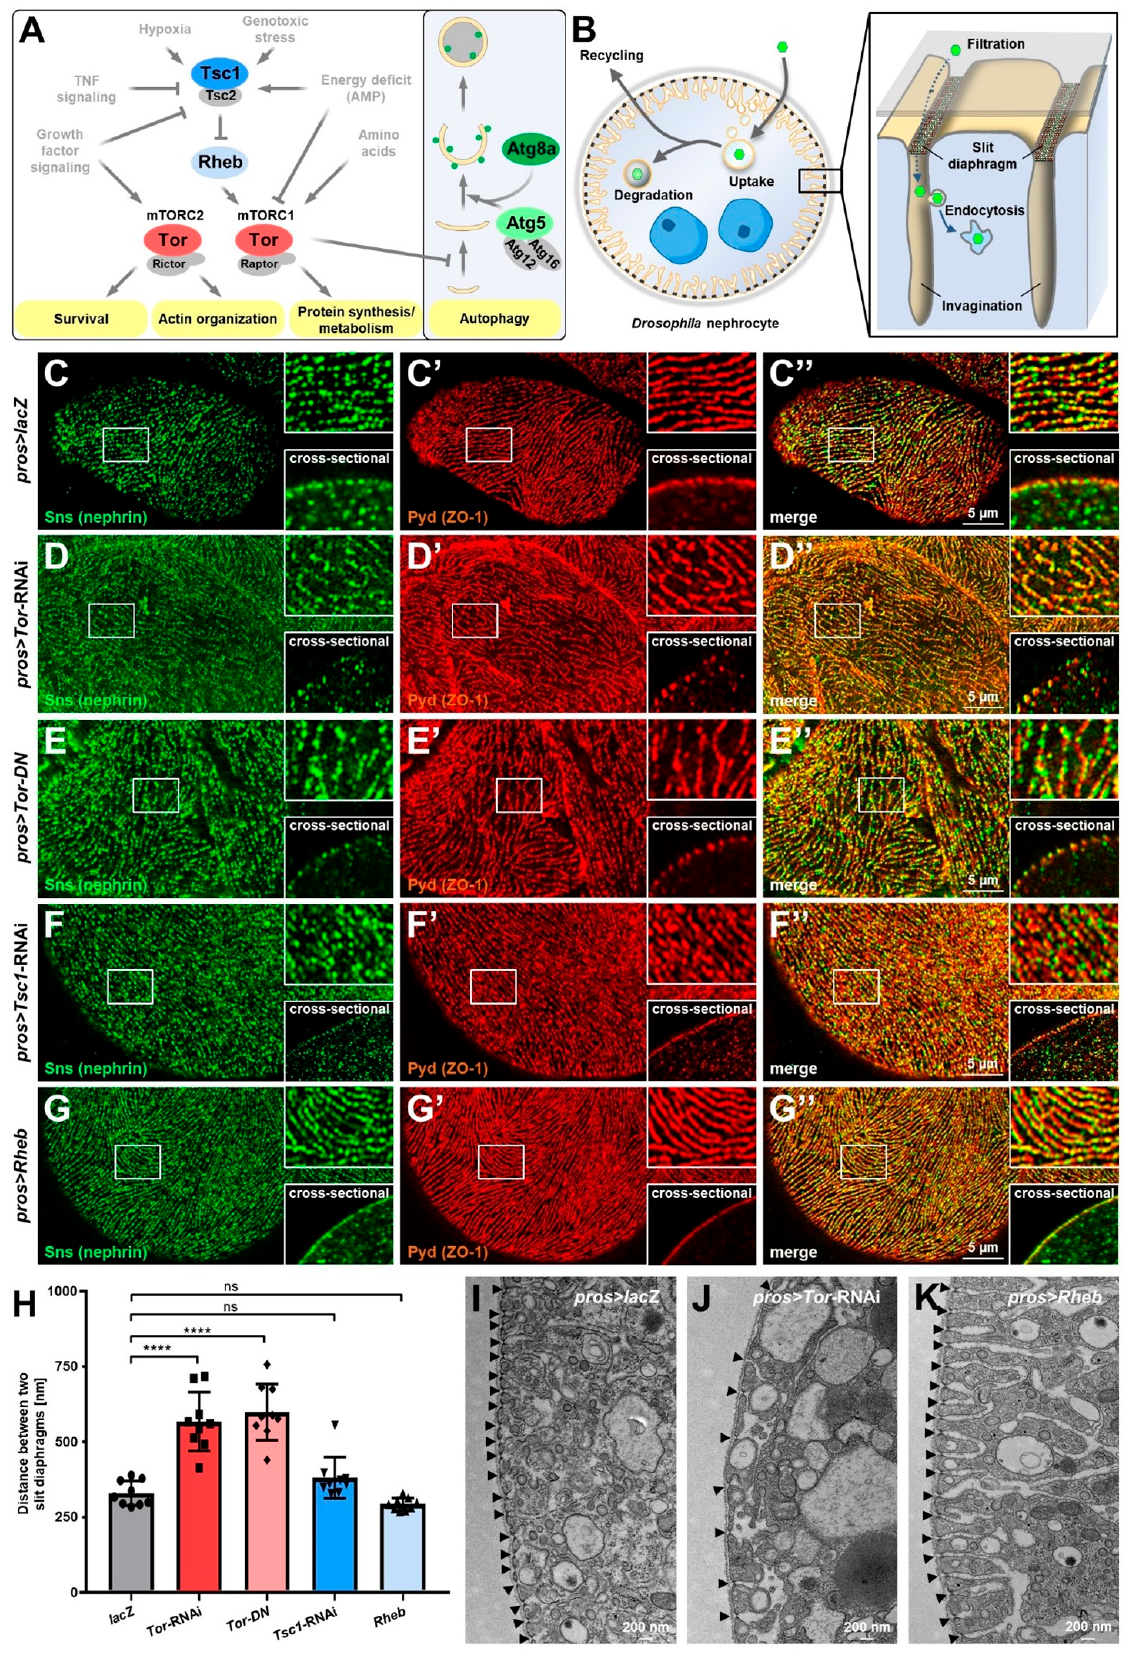
Figure 1. Inhibition of mTOR signaling increases spacing of slit diaphragms in Drosophila